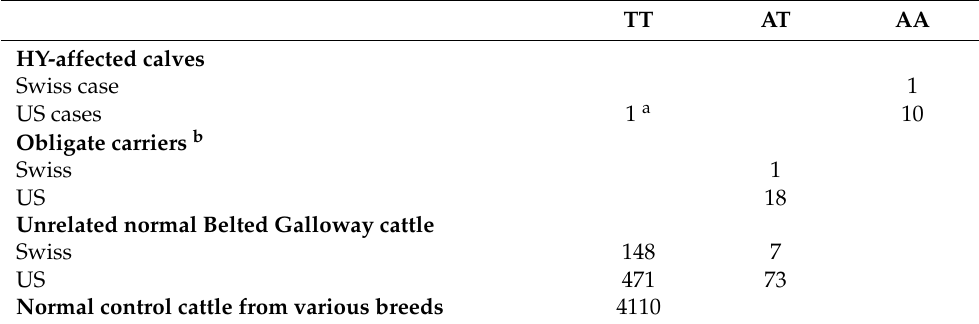
Table 1. Association of the nonsense variant in HEPHL1 with the hypotrichosis phenotype in Belted Galloway cattle.